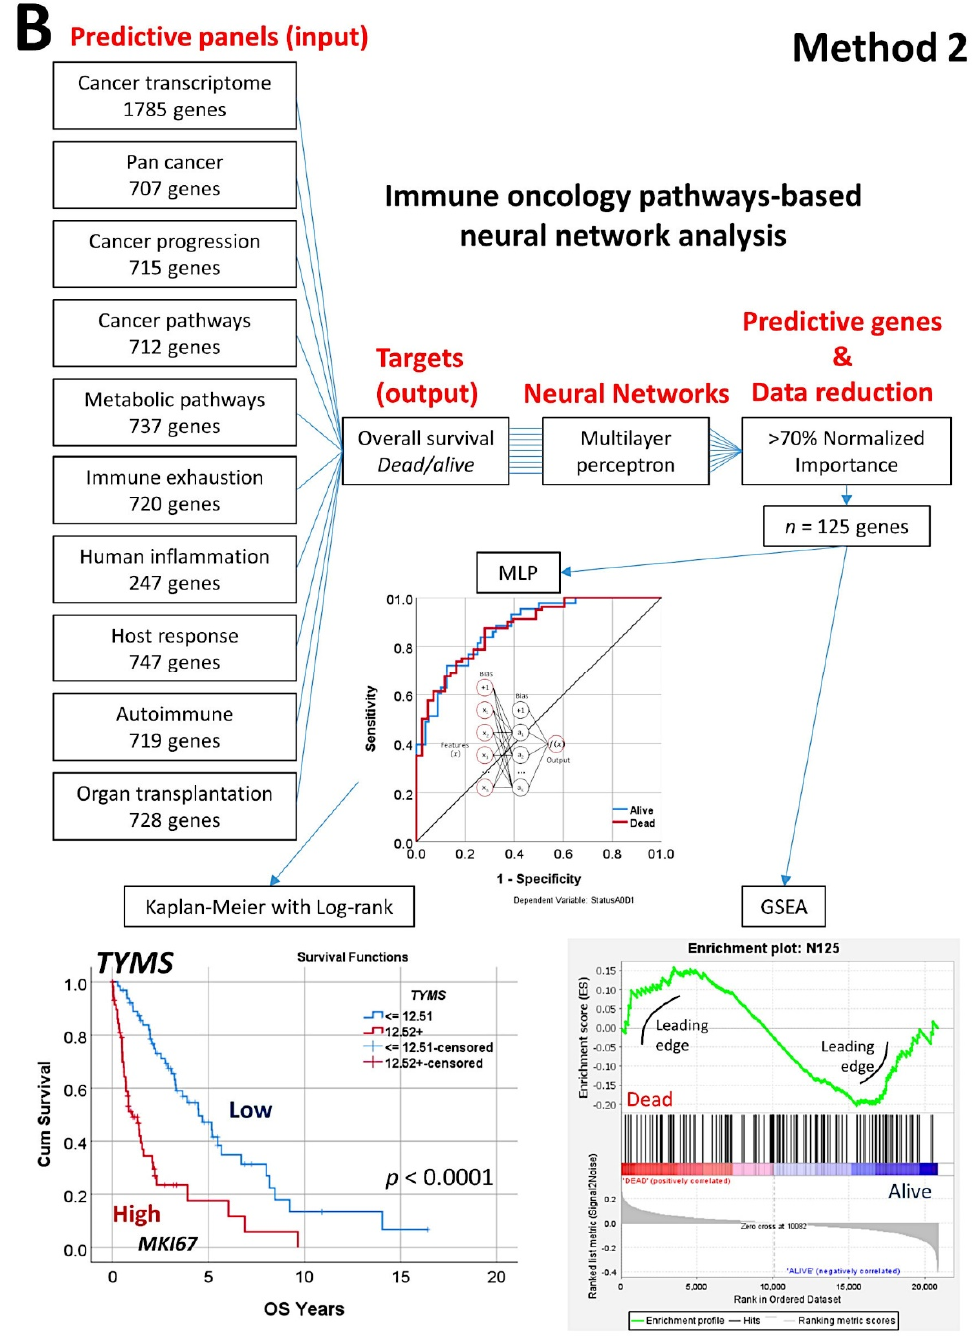
Figure 9. Prediction of the overall survival of mantle cell lymphoma using an algorithm based on neural networks. Two methods ( A and B algorithms) were designed. Method 1 used as input 20,862 genes to predict the overall survival outcome (dead vs. alive) and other prognostic markers; because of dimensionality reduction, a final set of 19 genes were highlighted. The analysis also included testing the final 19 genes with other machine learning analysis, and conventional overall survival with log-rank test. Method 2 used as input several gene panels to predict the overall survival. As a result, 125 pan-cancer and immuno-oncology genes were highlighted. The association with the patients overall survival was confirmed by GSEA and conventional overall survival with log-rank test. OS, overall survival; MLP, multilayer perceptron; RBF, radial basis function; GSEA, gene set enrichment analysis; D/A, dead/Alive; AUC, area under the curve; NI, normalized importance.